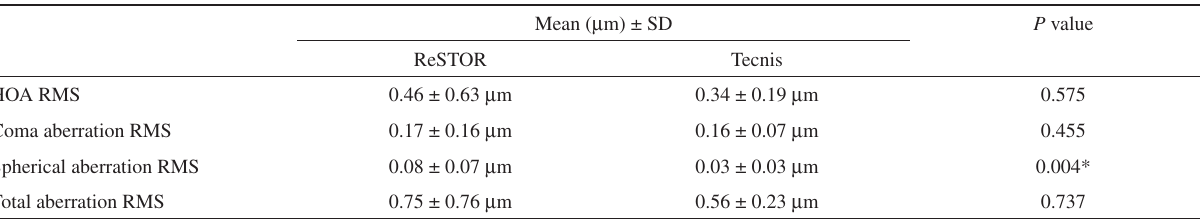
Table 2 - Wavefront data with 5 mm pupil